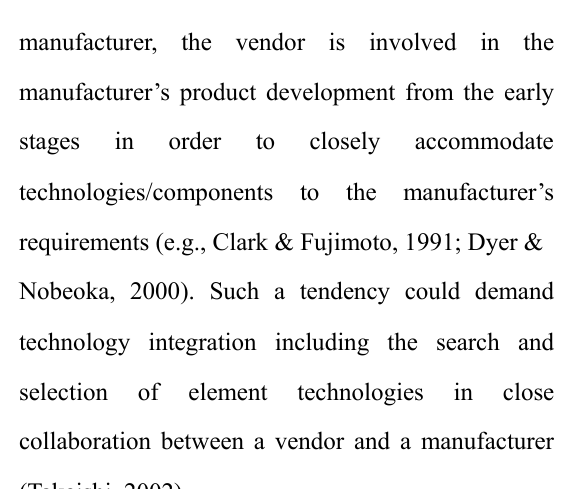
Figure 4 . The range of